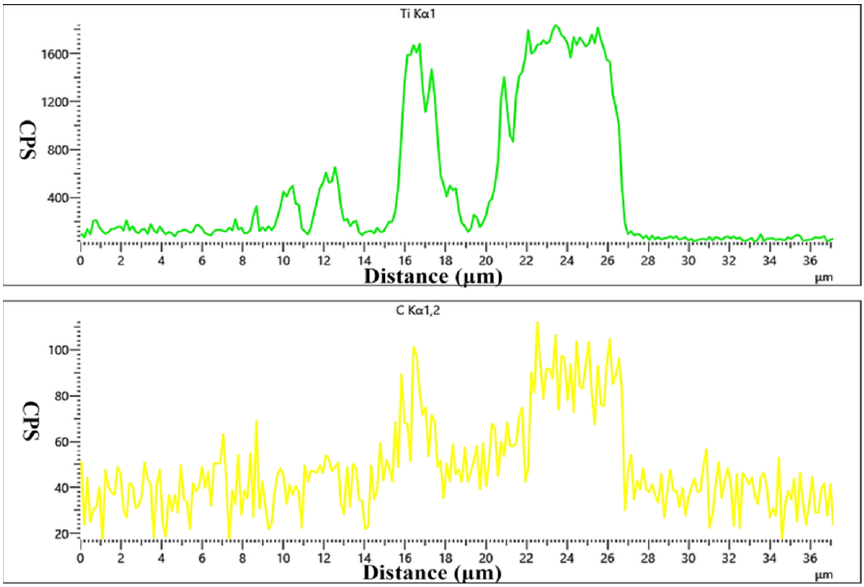
Figure 12. Concentration curve of Ti and C.